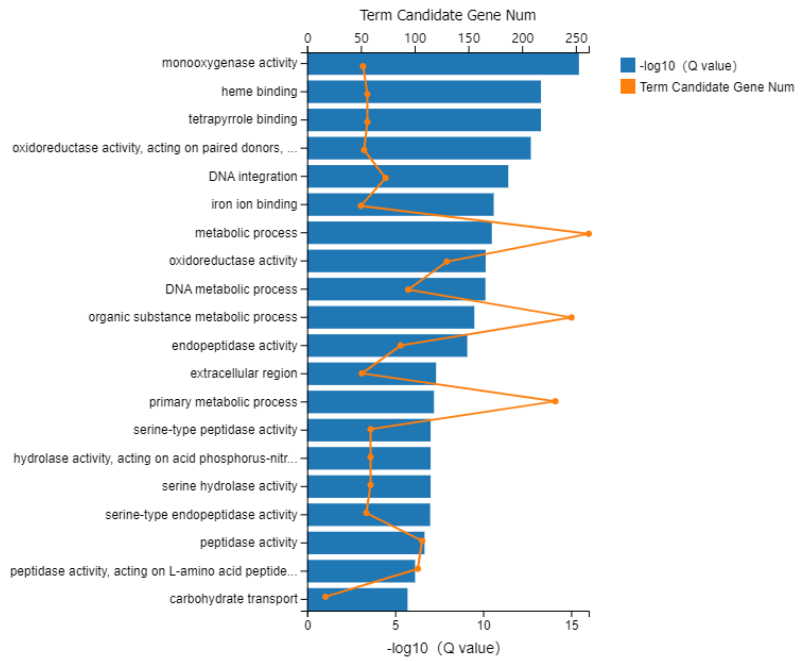
Figure 4. GO function enrichment analysis. GO enrichment results for DEGs in F A W A versus F E W E . Note: The length of the X-axis column represents the size of the Q value ( − log10( Q value)), and the value of the point on the polyline on the upper X is the number of differential genes annotated to the GO term.